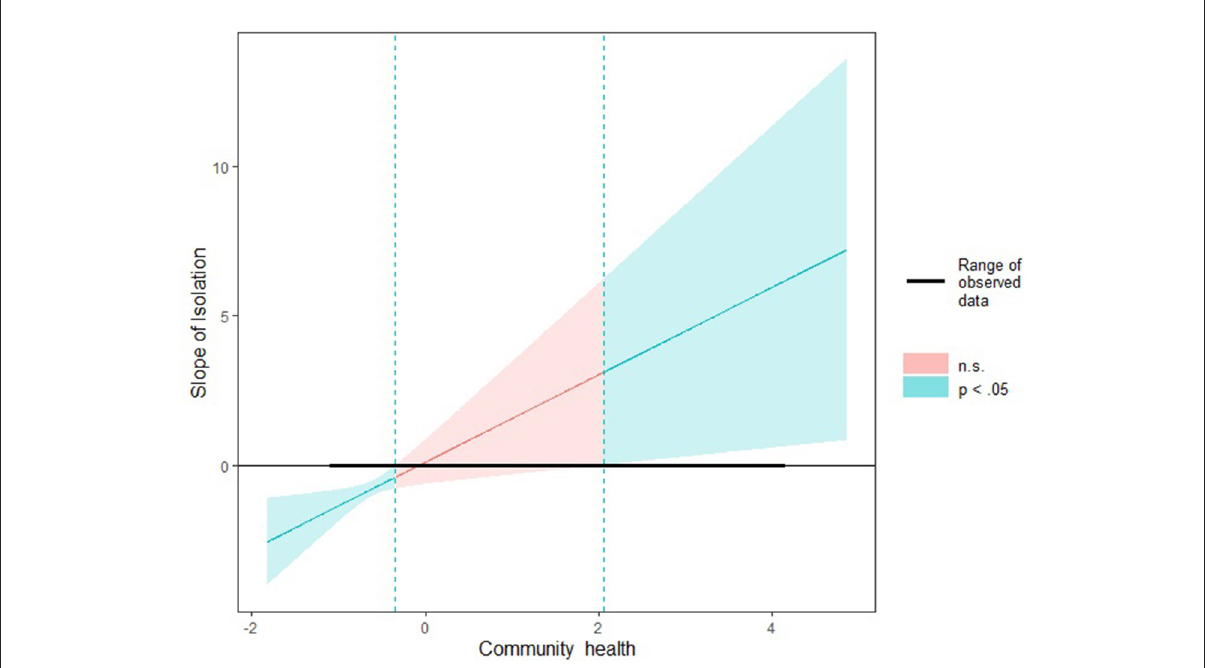
FIGURE2 The moderation effect of community health in the relationship between residential segregation and viral suppression: A Johnson-Neyman interaction plot.